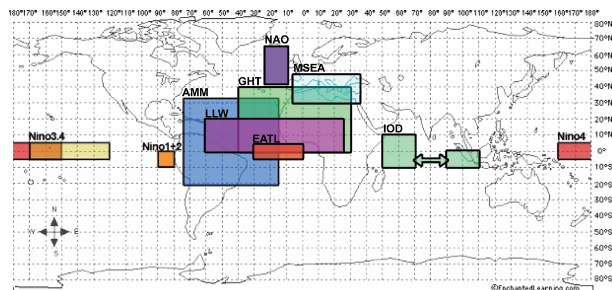
Figure 4. Spatially defined variables’ anomaly presence or absence is affixed to climate index anomalies expanded to represent a global